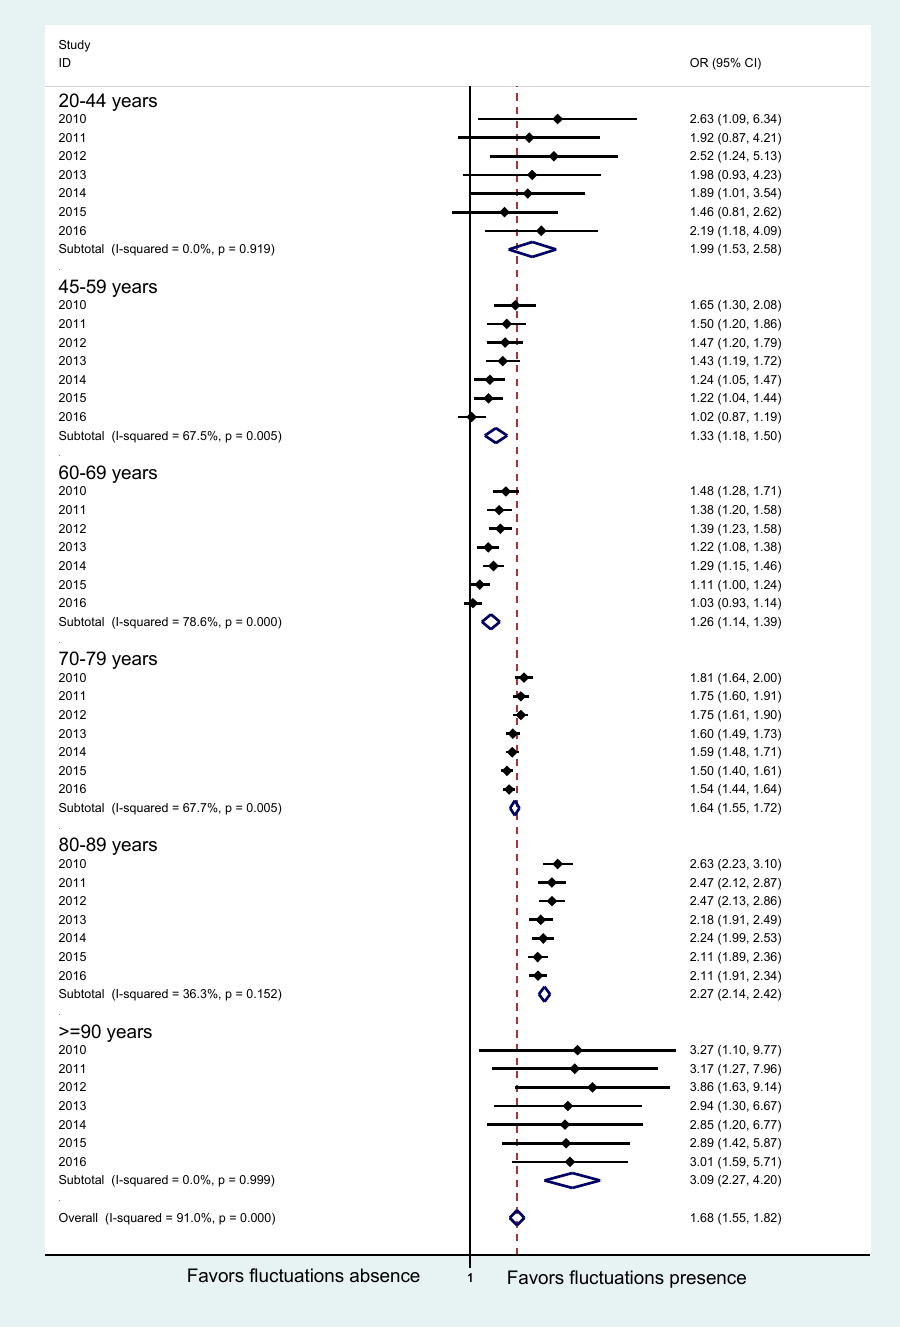
Figure 5. Odds ratio for primary Parkinson syndrome with or without motor fluctuations to receive PD-MCT between 2010 and 2016. Horizontal bars depict estimated odds ratios (ORs) with the corresponding 95% confidence intervals (CI) to receive PD-MCT depending on a diagnosis without (left) or with (right) motor fluctuations in specified years for predefined age groups. Diamonds depict respective averages of the years 2010–2016 for predefined age groups and the overall